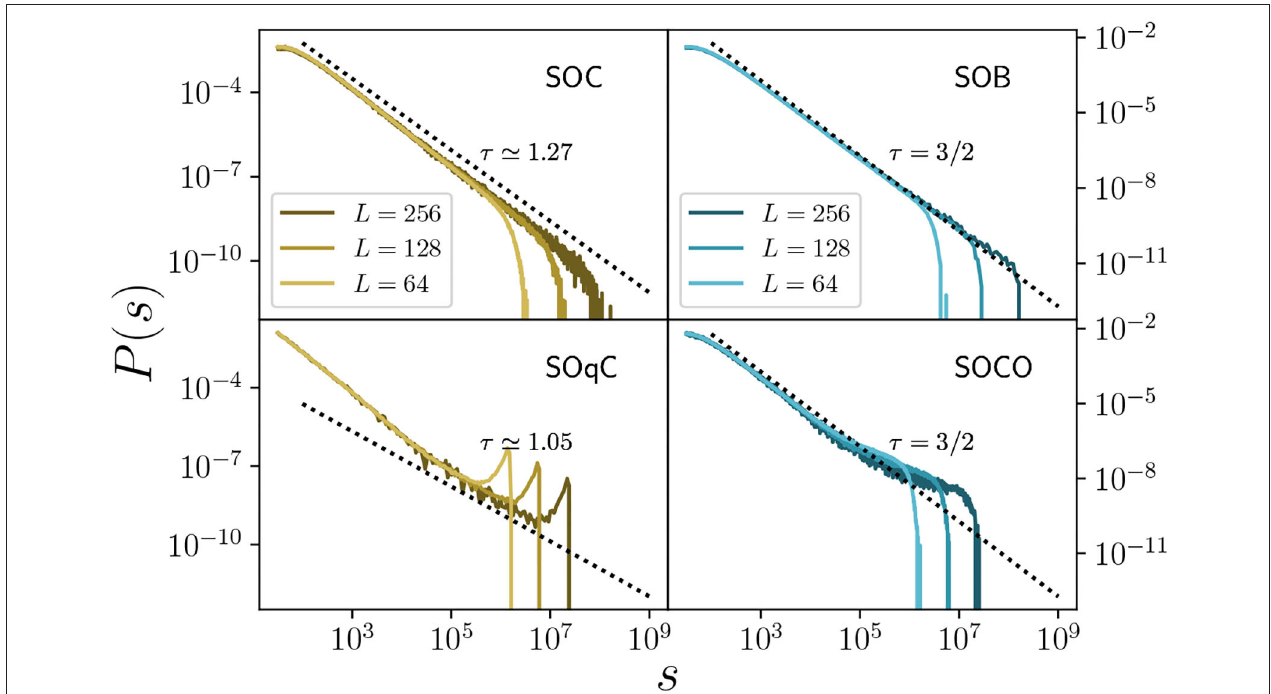
FIGURE 4 | Avalanche size distributions for the four different types of self-organization mechanisms in two dimensional lattices. For the cases of SOC and SOB (upper panels) the distribution can be fitted by a power law in an exact way in the thermodynamic limit, while it is truncated—in a scale-invariant way—in finite systems. For SOC, the distributions show scaling that belongs to the C-DP or Manna class. In the case of SOB, power-laws are also obtained, and show mean-field exponents (including logarithmic corrections to scaling as the upper critical dimension is 2, see main text); also, note the bump at the end of the distribution, due to “king” events, effect that can be made more apparent by increasing the value of b in the Langevin equation (i.e., making the jump at the discontinuity of the phase transition more abrupt). For the cases of imperfect self-organization (i.e., non-conserved) either SOqC or SOCO (lower panels), the distributions can be fitted by power-laws only in an approximate way. This is a consequence of the fact that, in these cases, the control parameter does not settle to a precise (critical) value but keeps hovering around the edge of the transition even in the thermodynamic limit. Parameter values are as in Table A1 , except for SOB, for which b was reduced to b excessively large “king”